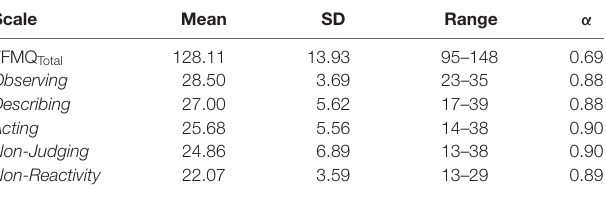
TABLE 1 | Scoring statistics and Cronbach’s Alpha ( α ) for each scale of the Five-Facet Mindfulness Questionnaire